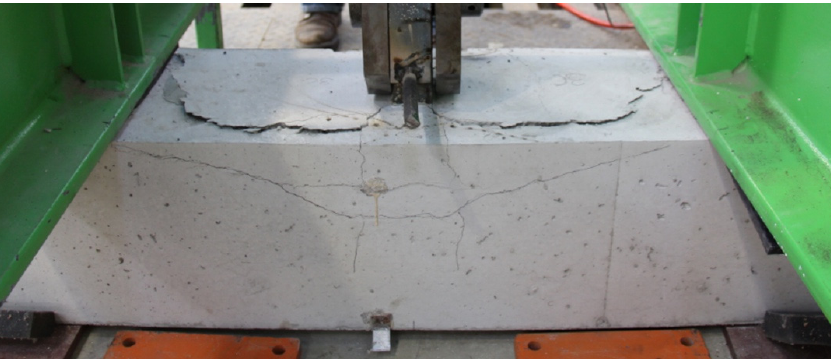
Figure 7. Modified concrete cone failure—specimen 3C.